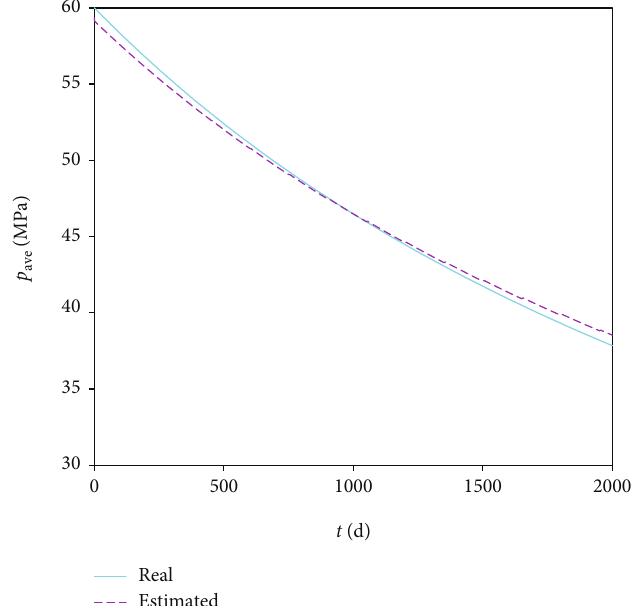
Figure 15: The real and estimated pro fi les of average reservoir pressure for the gas well under variable BHP and variable production rate